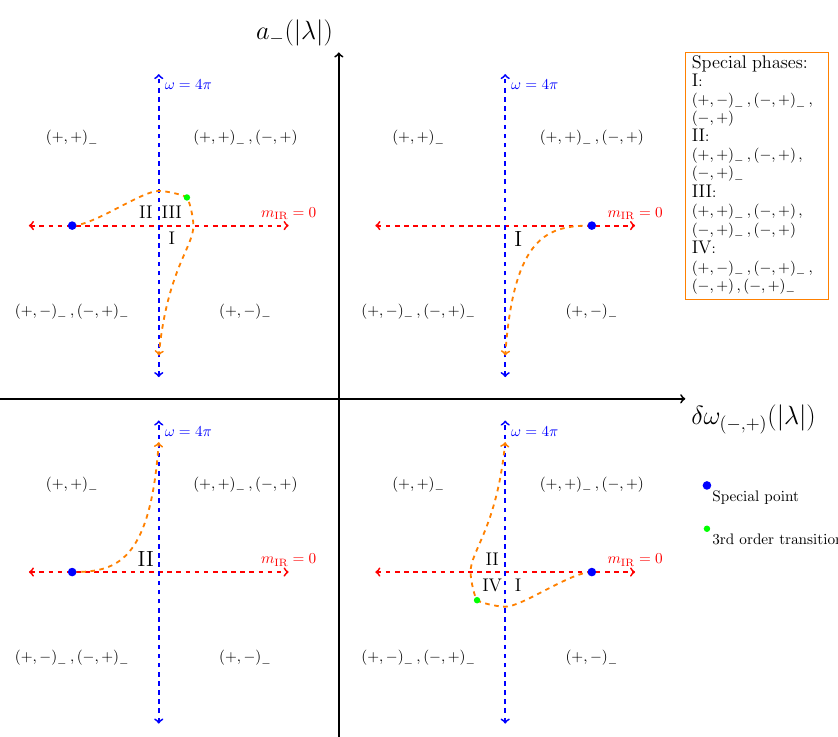
Figure 8. Possible changes to the ( − , +) “special phase” at large values of λ .